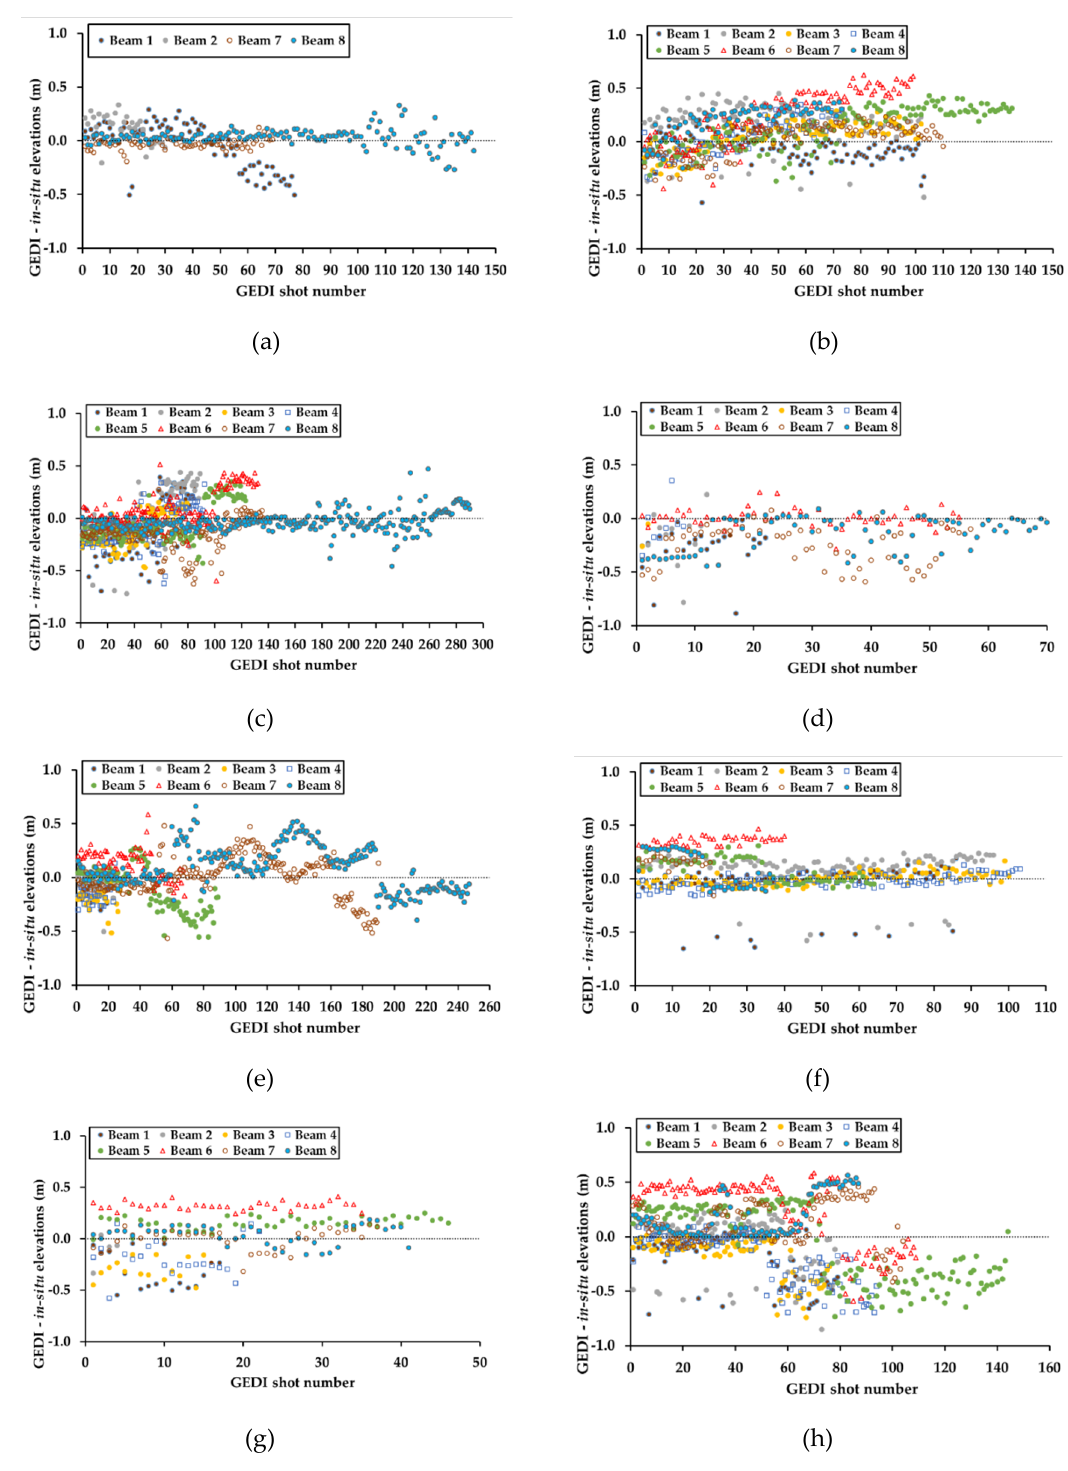
Figure A1. Difference between GEDI and in-situ elevations of all shots acquired over water for each lake on all dates, plotted for each beam (1 to 8). Abscissa = GEDI shot number. ( a ) Geneva, ( b ) Neuchâtel, ( c ) Zürich, ( d ) Obersee (Zürich), ( e ) Lucerne, ( f ) Walensee, ( g ) Sempach, and ( h ) Thun.